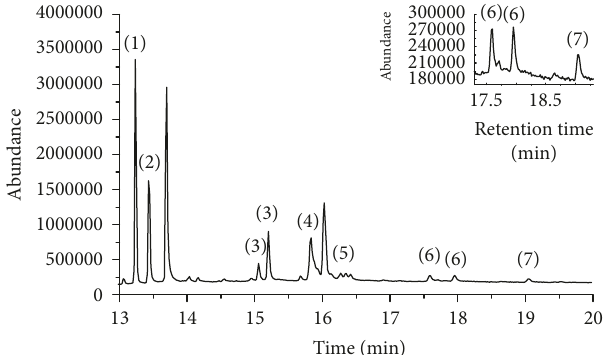
Figure 2: GC-MS chromatogram of the mixed standard solution of 7 pyrethroids. (1) bifenthrin, (2) fenpropathrin, (3) permethrin, (4) cyfluthrin, (5) cypermethrin, (6) fenvalerate, and (7) deltamethrin.